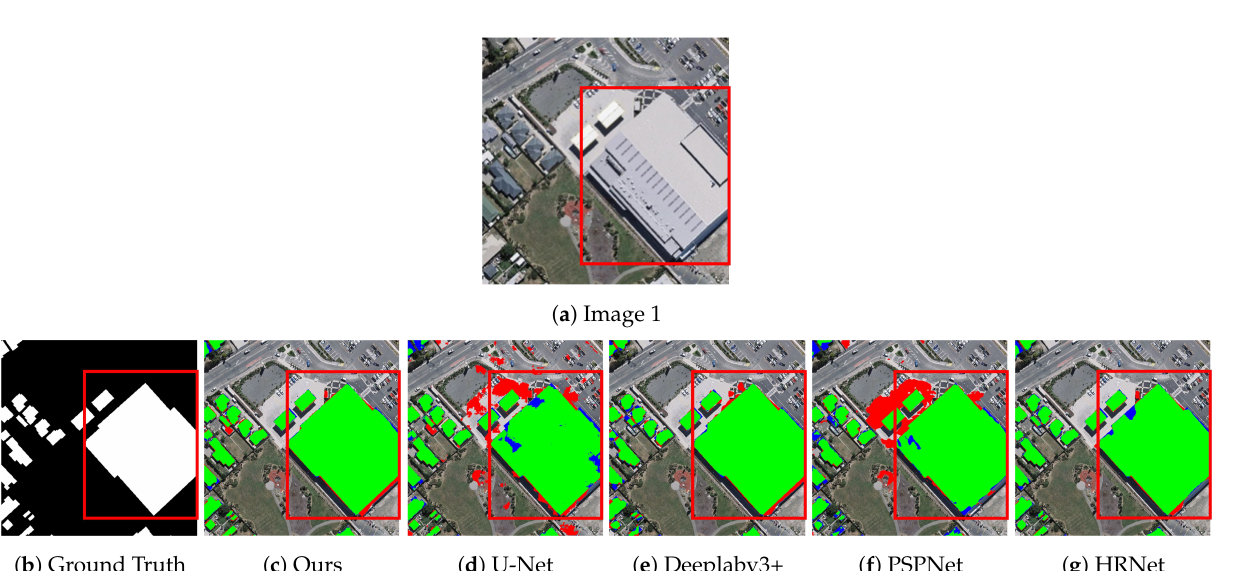
Figure 6. Results of different methods on large buildings with complex textures and colors. ( a ) Orig- inal image; ( b ) ground truth; ( c ) the results of our CFENet; ( d – g ) show the results of U-Net, Deeplabv3+, PSPNet, and HRNet, respectively. Green, red, and blue pixels on the map repre- sent predictions of true positives, false positives, and false negatives, respectively. The experimental results in the red box show the areas where the contrast effect is more